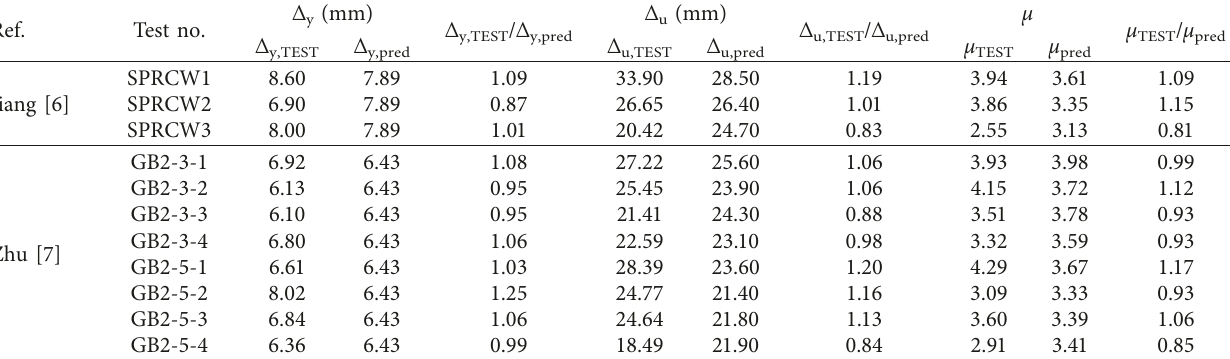
Table 6: Comparison of deformation capacity between tests and predicted